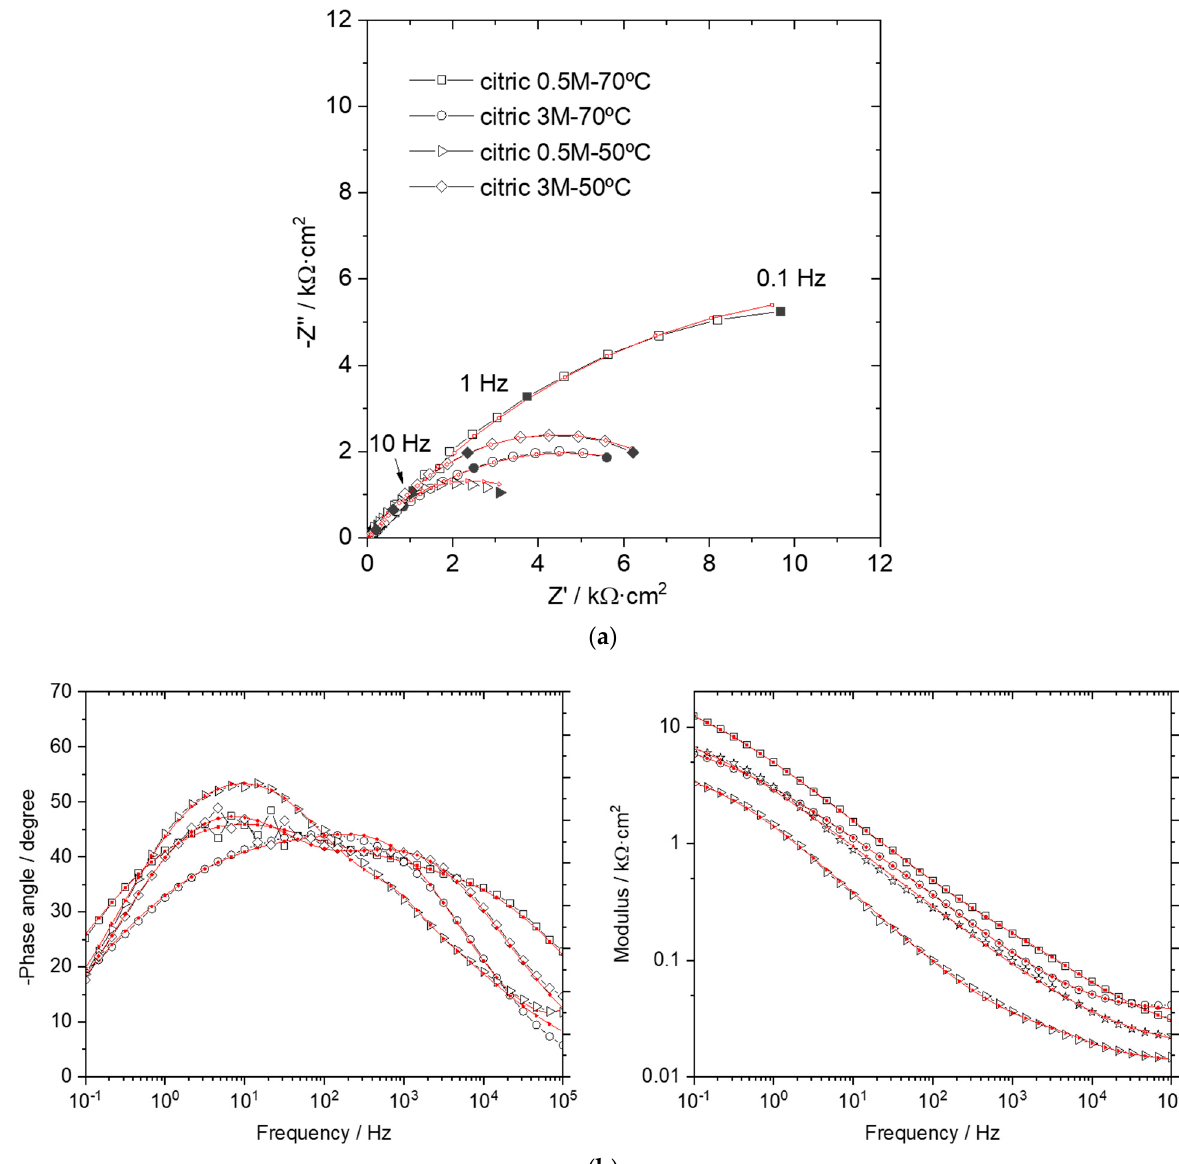
Figure 5. Impedance spectra obtained in 0.1 M Na 2 SO 4 for the phosphate layers prepared after pickling with citric acid: ( a ) Nyquist plots; ( b ) Bode plots. Red lines denote the fitted curves.